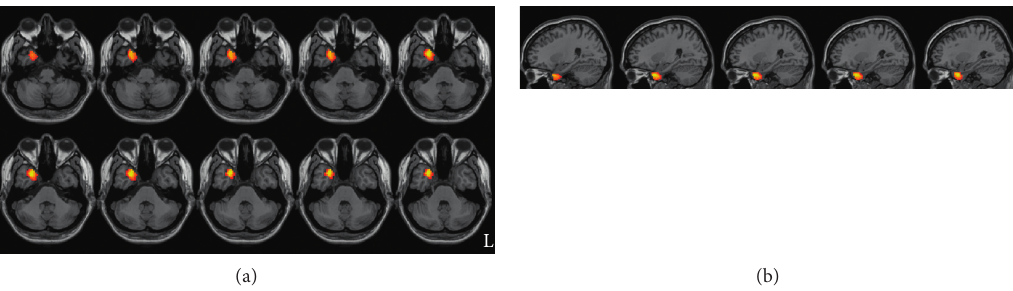
Figure 1: The ReHo difference between the LPD group and the control group. (a) and (b) are axial and sagittal views, respectively. LPD patients had increased ReHo in the right temporal pole compared with the controls. L indicates the left side. Table 2: Brain regions with significant differences in ReHo between PD patients and control subjects. Brain regions